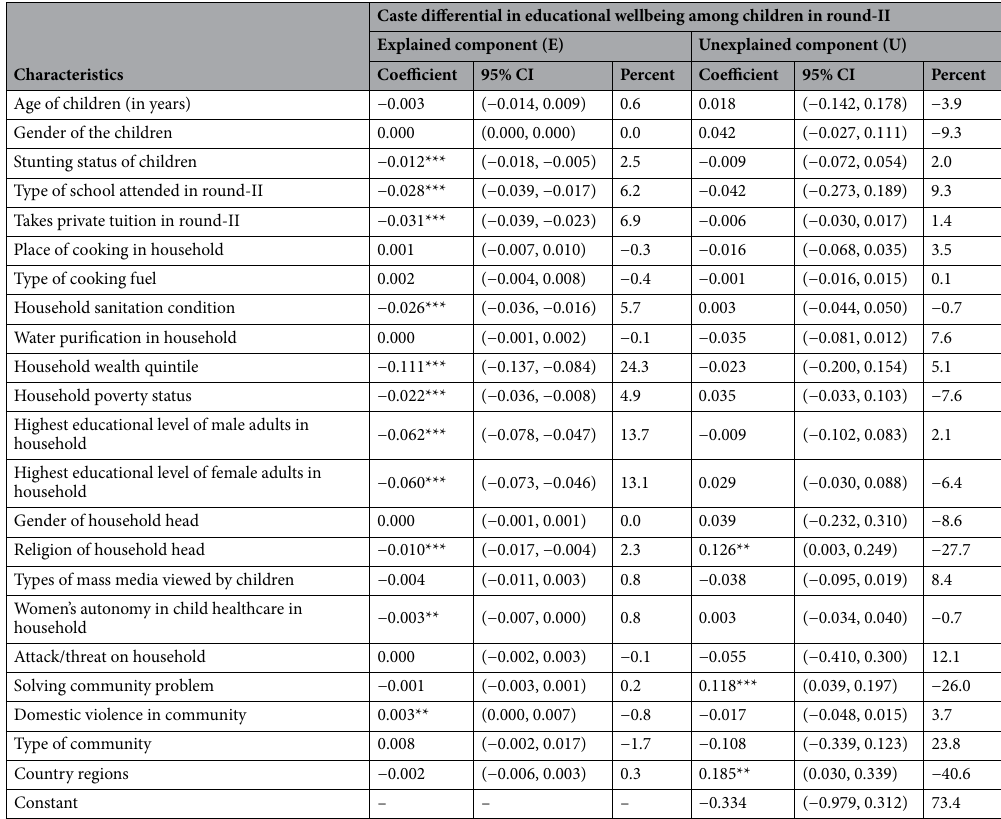
Table 4. Detailed Blinder-Oaxaca decomposition of the caste differential in educational wellbeing score of the panel of children during IHDS round-II. (a) CI confidence interval; (b) statistical significance denoted by asterisks where *p-value < 0.1, **p-value < 0.05 and ***p-value <